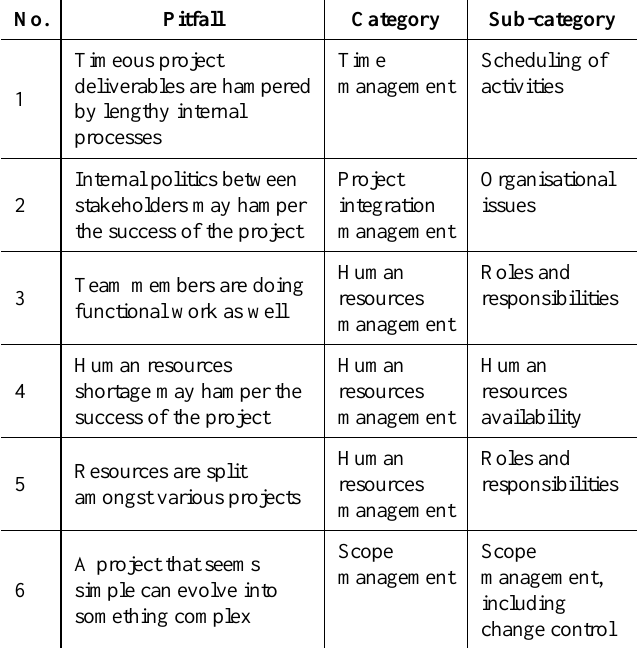
Table 5: Categorisation of high-level pitfalls